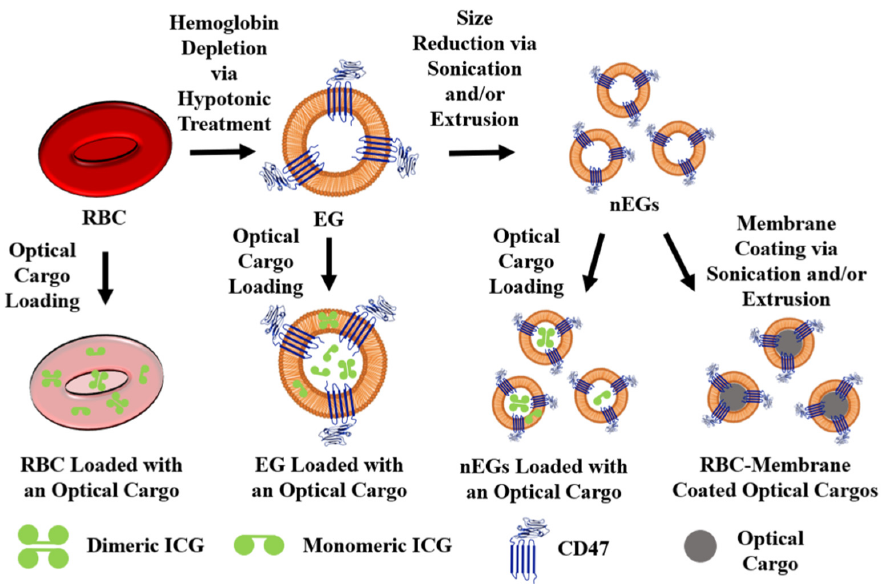
Figure 3. Schematic illustration of RBCs, EGs, and nEGs loaded with an optical cargo to serve as RBC-derived carriers. For illustration purposes CD47 is shown as one of the RBC transmembrane proteins retained on EGs. A representative spherical nanoparticle, to be coated with RBC membrane, is shown as the optical cargo for constructs formed using sonication and/or extrusion. Indocyanine green (ICG) is shown in its dimeric and monomeric forms as a representative optical cargo.